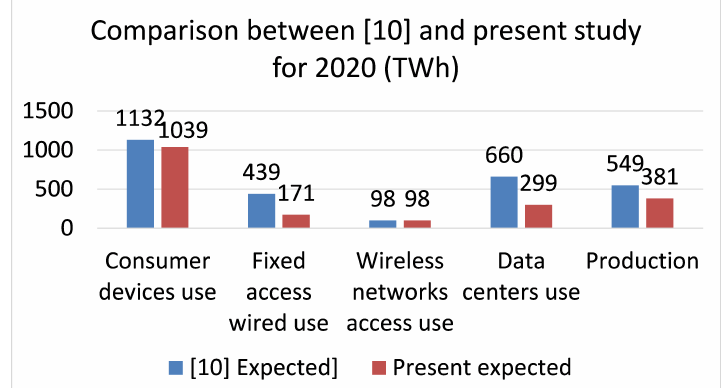
Figure 5. Trends for ICT electric power overall 2020.